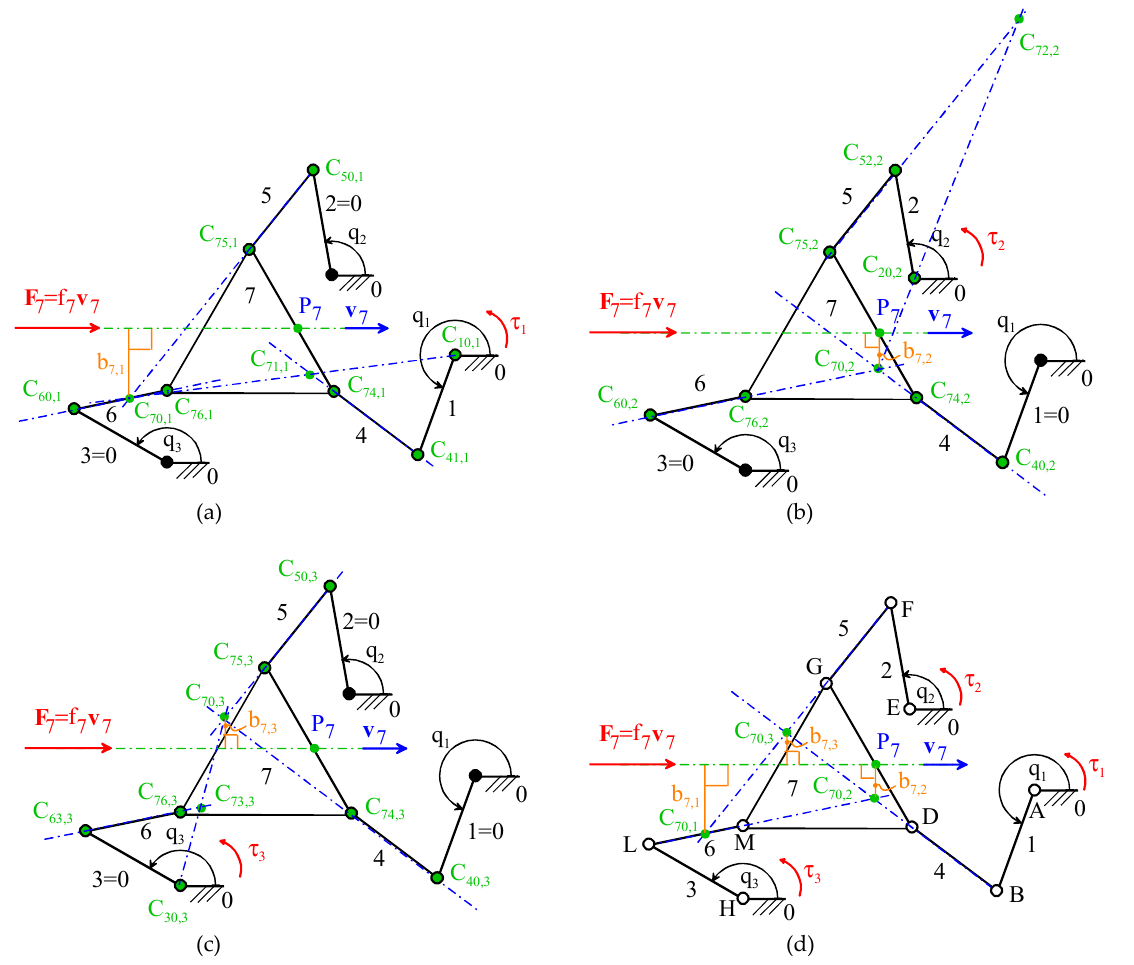
Figure 11. Active-load diagrams of the three single-DOF PMs generated from the 3-RRR parallel PM: ( a ) r = 1 (i.e., q 2 and q 3 are locked), ( b ) r = 2 (i.e., q 1 and q 3 are locked), ( c ) r = 3 (i.e., q 1 and q 2 are locked), ( d ) extract of the previous diagrams that is useful to visualize how an active force is redistributed among the